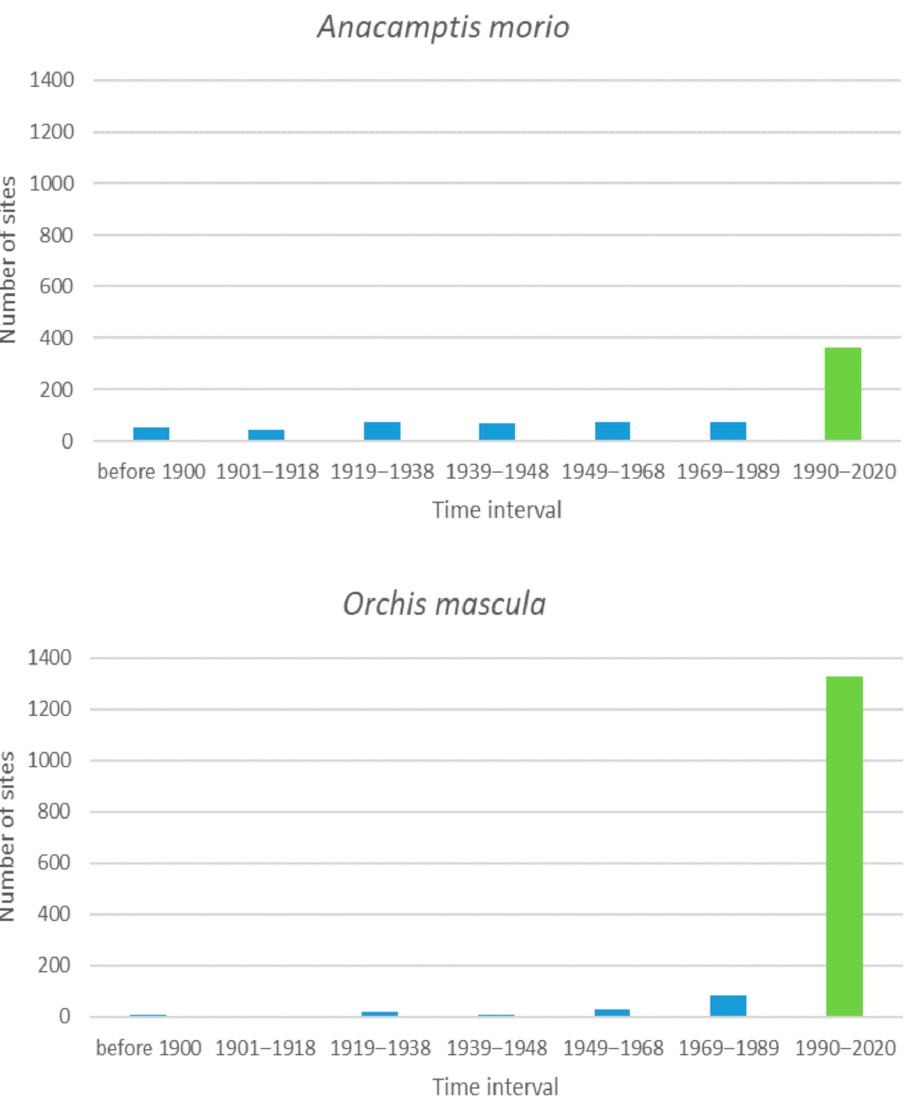
Figure 5. The number of sites that were occupied by orchids for the last time during the given interval and then were no longer occupied for the two species that were found historically at more than 300 sites. The green bar indicates the number of sites observed as extant in the last interval, which we consider as extant currently.